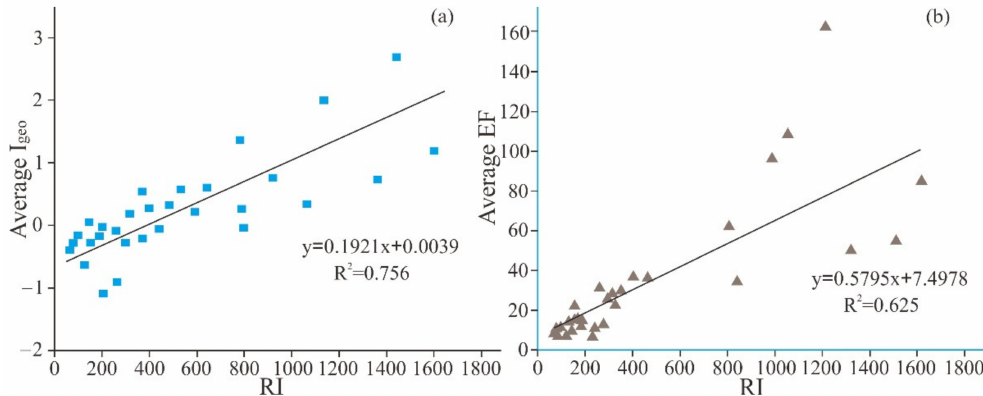
Figure 8. ( a ) Regression analysis between RI and Igeo; ( b ) Regression analysis between RI and